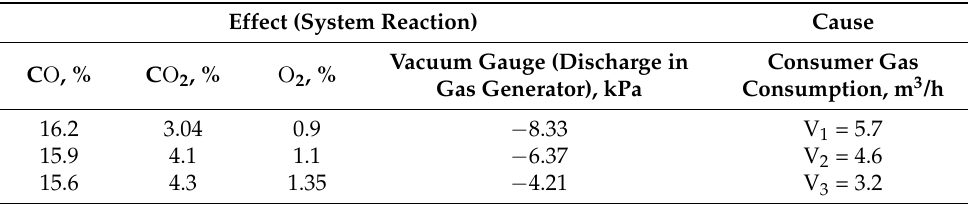
Table 1. Change in the chemical composition of generator gas depending on its uptake.